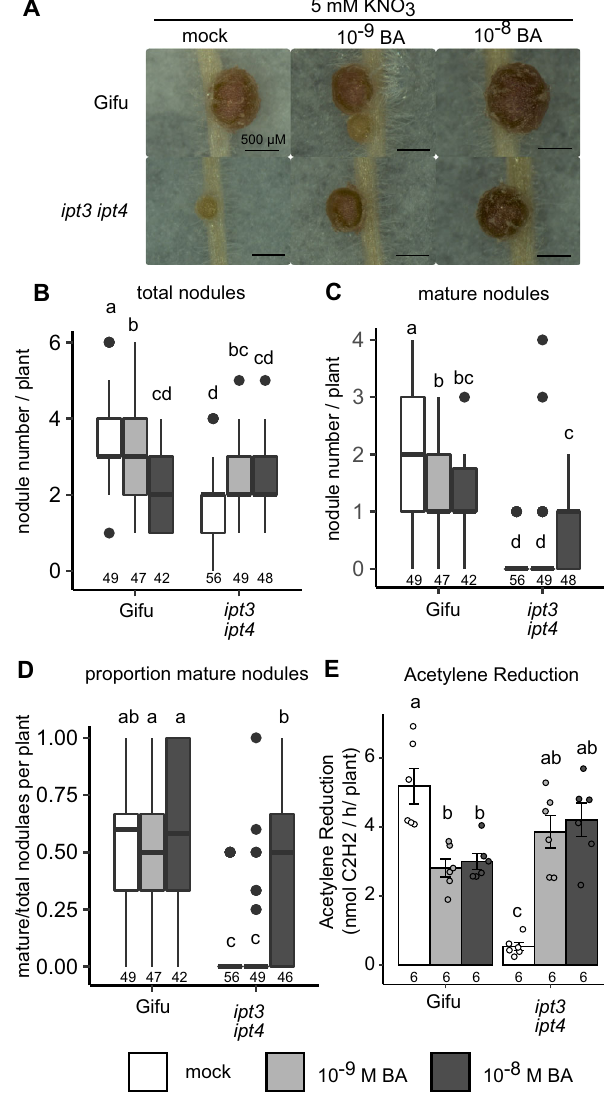
Fig. 5 Nitrate inhibition of nodule development can be rescued by cytokinin application. A Images of nodules developed in the presence of 5 mM KNO 3 with mock, 10 -9 or 10 -8 M BA at 14 dpi with M. loti on the indicated host genotypes. Scale bar = 500 μ M. B – D Development of total ( B ), mature ( C ) and the proportion of mature nodules ( D ) in the presence of 5 mM KNO 3 with mock, 10 -9 or 10 -8 M BA at 14 dpi with M. loti . E Nitrogenase activity assessed by ARA at 21 dpi with M. loti in the presence of 5 mM KNO 3 with mock, 10 -9 or 10 -8 M BA. Box plots show Min, Q1, Median, Q3, Max and outlier values in nodulation assays ( B – D ). For ARA ( E ), bars show mean ± SE. Signi fi cant differences among different genotypes and concentration of BA are indicated by letters ( p < 0.05) as determined by ANOVA and Tukey post-hoc testing. Pairwise P -values are available in the Source Data fi le. The n values of each group are